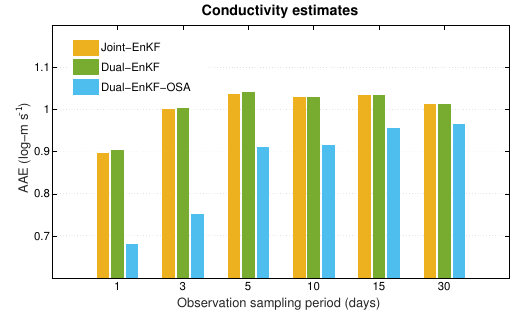
Figure 5. Mean average absolute errors (AAE) of log-hydraulic conductivity, log (K) , obtained using the joint EnKF, dual EnKF, and dual EnKF OSA schemes. Results are shown for six different scenarios in which assimilation of hydraulic head data are obtained from nine wells every 1, 3, 5, 10, 15, and 30 days. All six experi- mental scenarios use 100 ensemble members and 0.10m as the mea- surement error standard